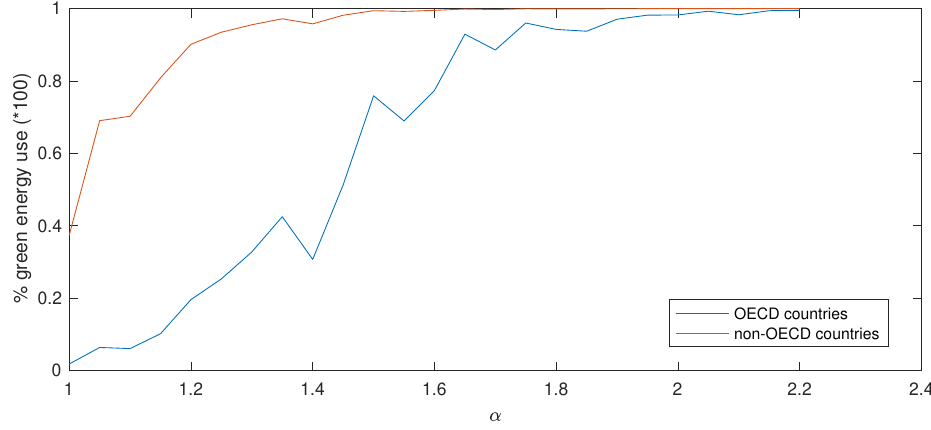
Figure 2. Percentage green energy with π = α · π initial with α ∈ [ 1,2.5 ]